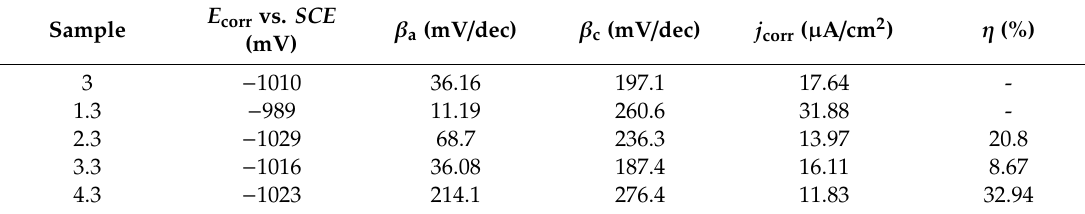
Table 5. Polarization test results in 1% NaCl, at a temperature (23 ± 2) ◦ C, with and without inhibitor.